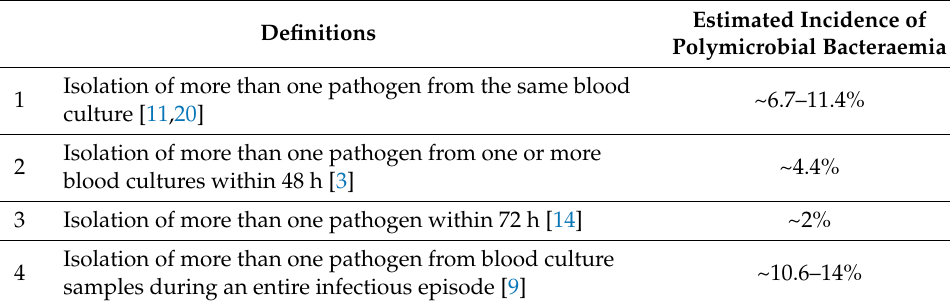
Table 1. Various definitions of polymicrobial bacteraemia used in the literature.